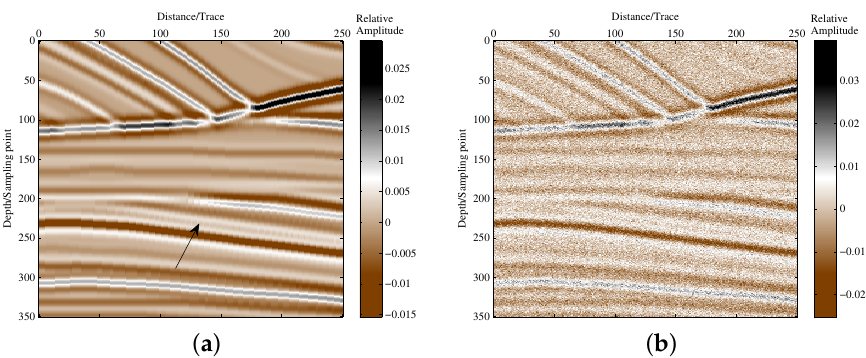
Figure 2. ( a ) A noise-free seismic section and ( b ) a noisy seismic section with a signal-to-noise ratio (SNR) of 3